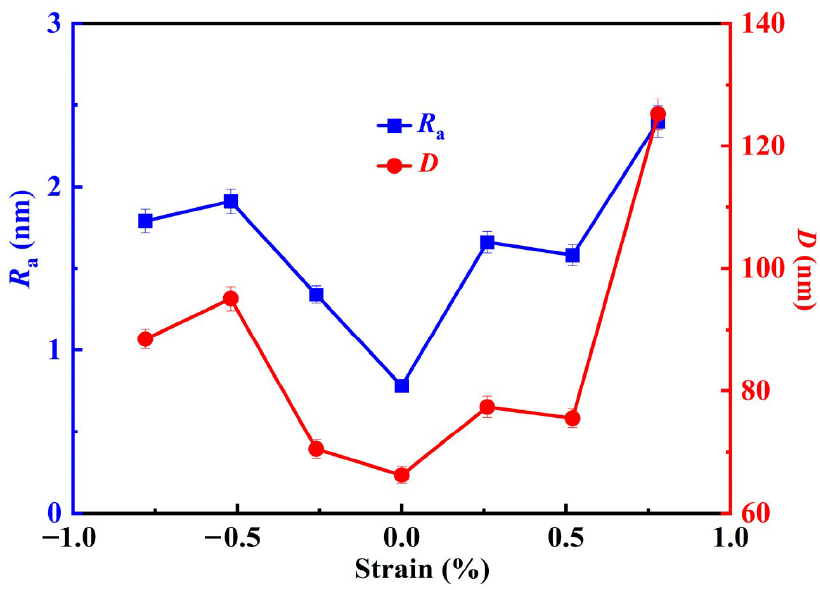
Figure 3. External strain dependence of surface roughness ( R a ) and average grain size ( D ) in TFNFT multilayer films.